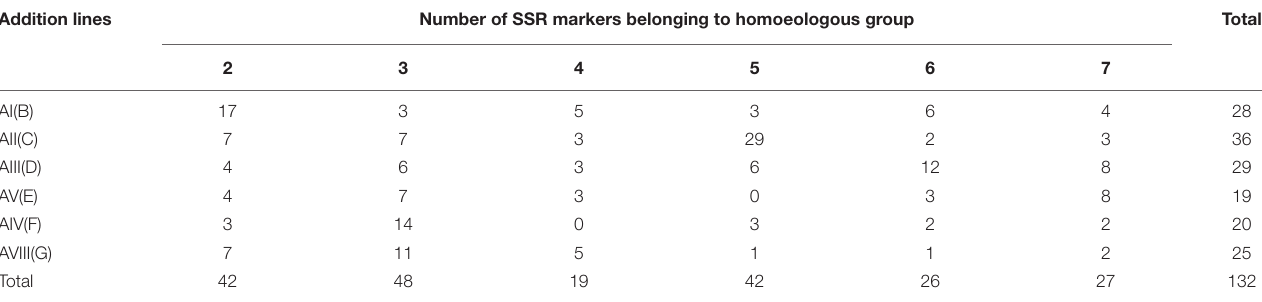
TABLE 2 | The distribution of the polymorphic SSR marker belonging to different homoeologous groups in six Alcedo- Aegilops markgrafii disomic addition lines. Addition lines Number of SSR markers belonging to homoeologous group